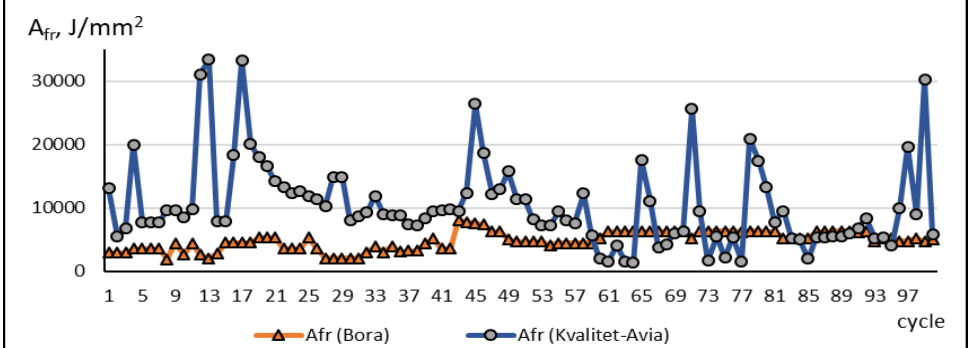
Fig. 5. Kinetics of changes in the specific work of friction in the course of